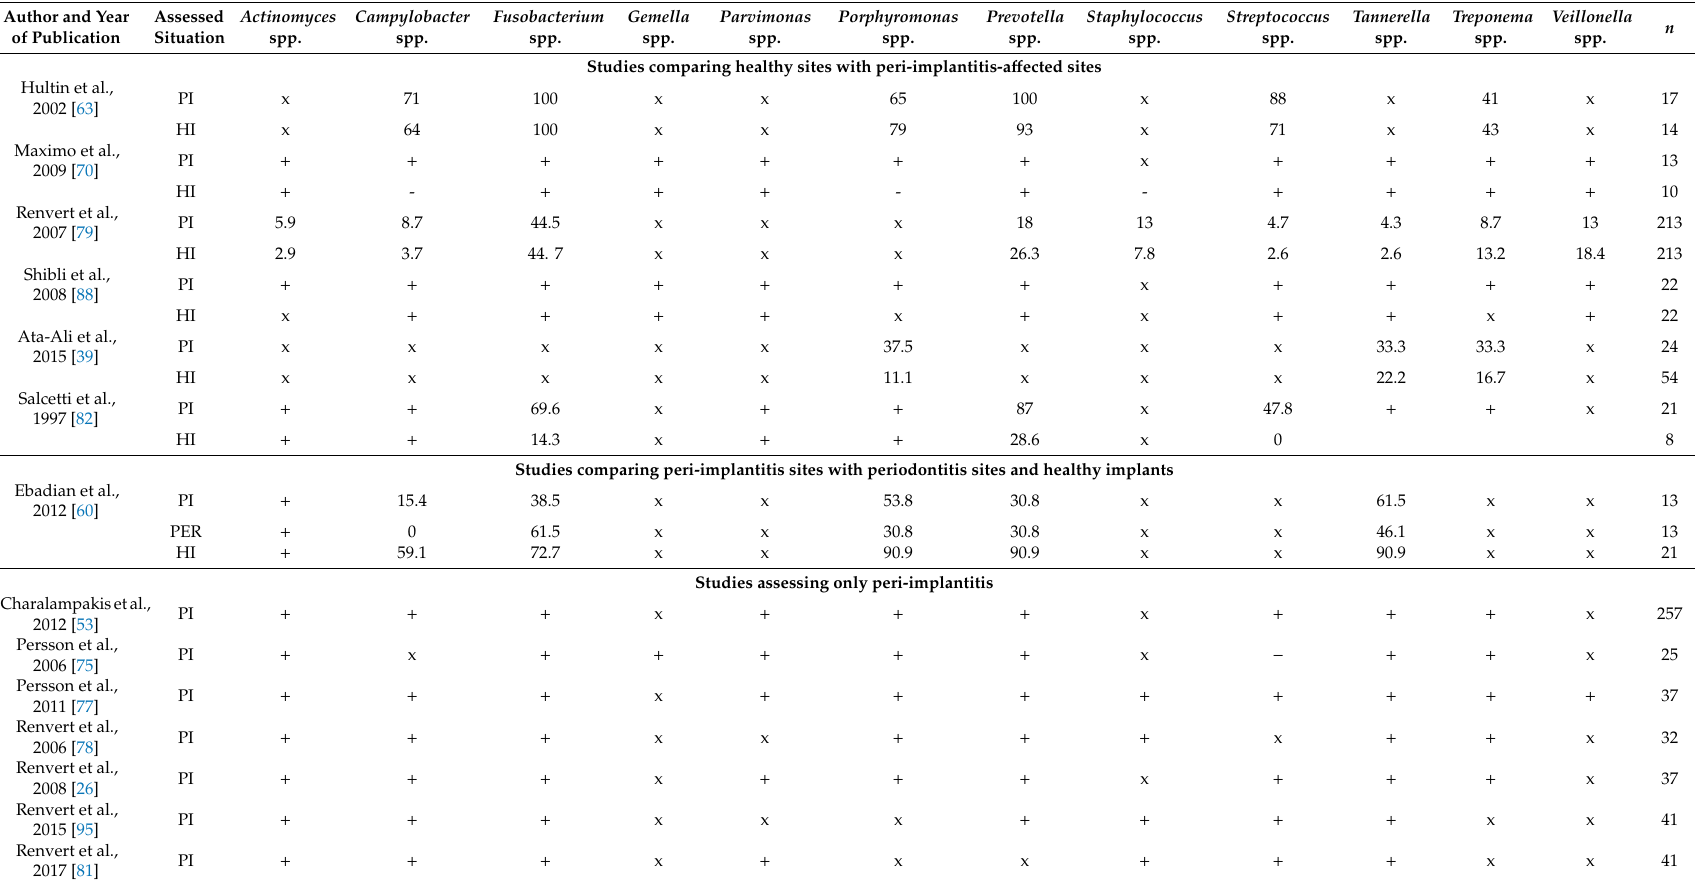
Table 4. Studies assessing di ff erent species using hybridization